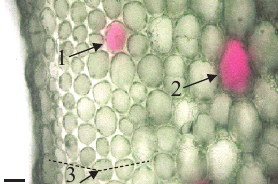
Fig. 5 – Anatomical cross section of the stem of Kalanchoe pinnata seedling grown under full sunlight. Arrow (1): Anthocyanin in collenchyma. Arrow (2): Anthocyanin in parenchyma. Arrow (3): Detail of annular collenchyma in Kalanchoe pinnata . Bar = 0.05mm.